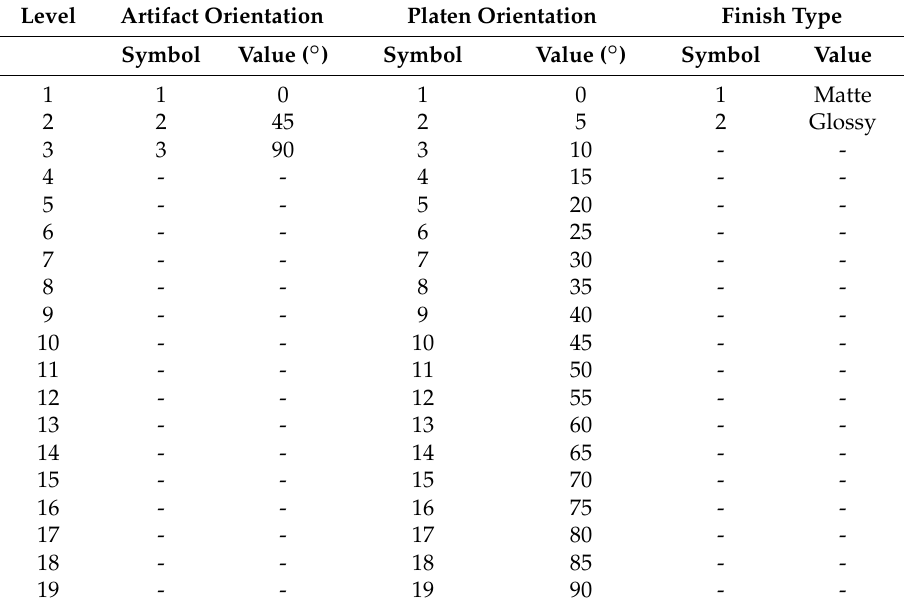
Table 3. Working conditions of EDEN 350 machine.